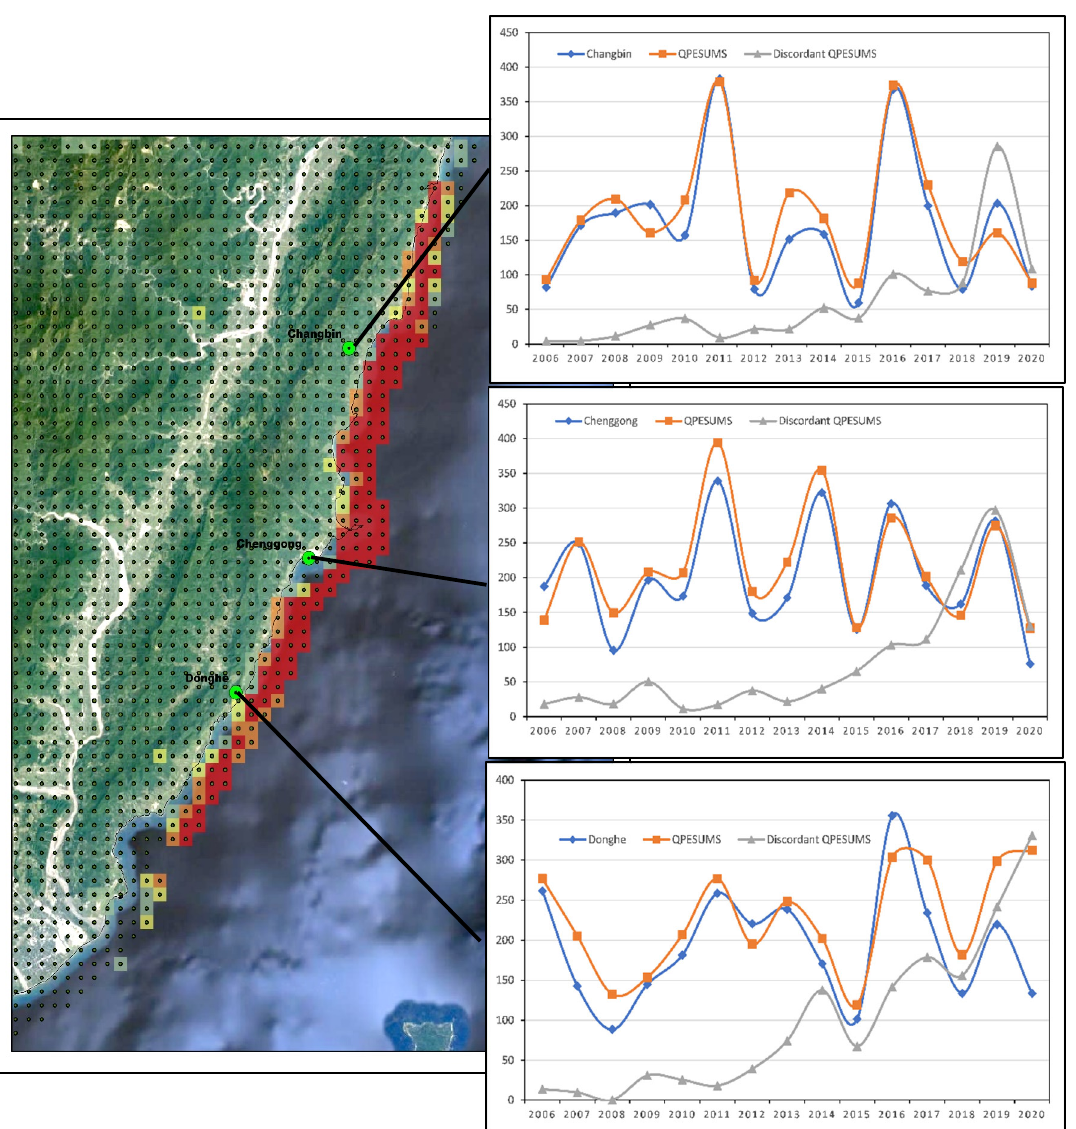
Figure 5. Discordant grids along the coastal in comparison with three closest rain gauges.